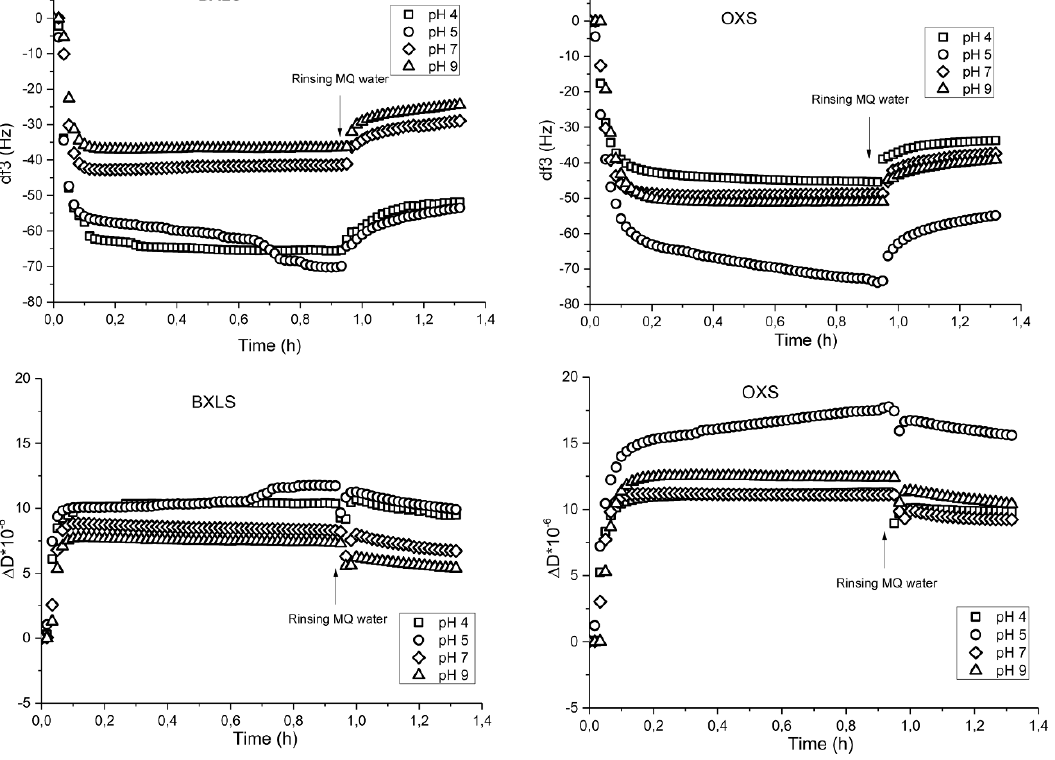
Figure 3. Frequency (third overtone) ( above ) and dissipation ( below ) changes as functions of time during the adsorption of sulfated glucuronoxylan (BXLS) and arabinoxylan (OXS) onto poly(ethylene terephthalate) (PET) model films at different pH values (pH 4, 5, 7 and 9).